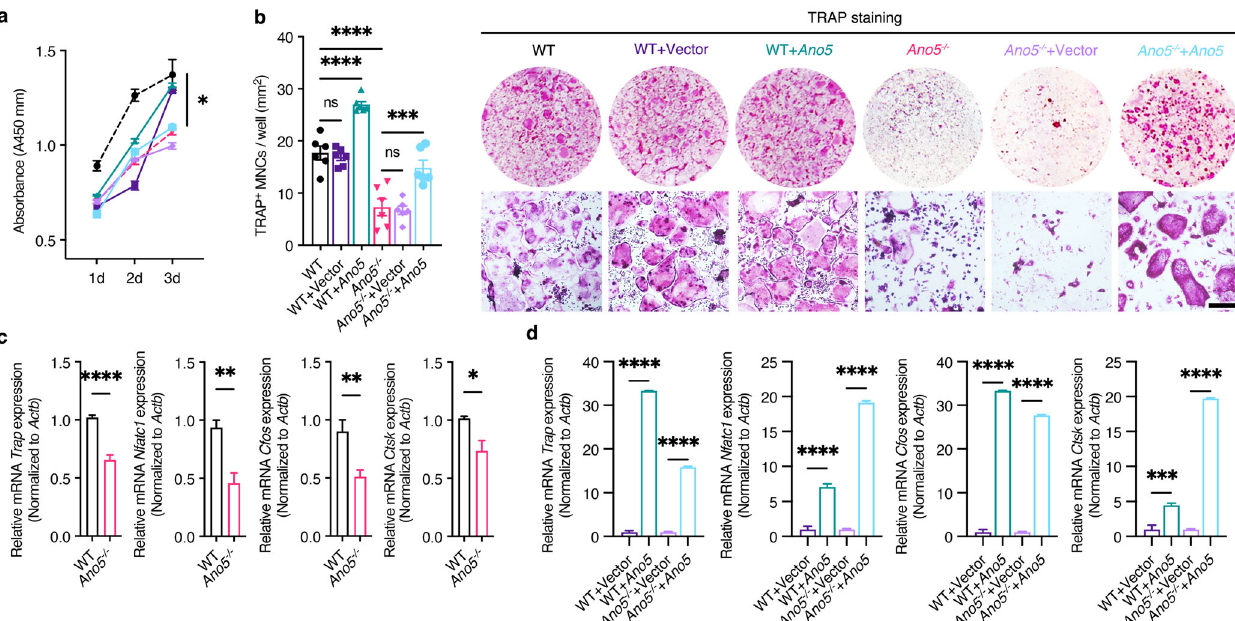
Fig. 4 Ano5 positively regulates osteoclast differentiation. a The proliferation of WT, Ano5 − / − BMMs, and those transduced with a control vector or Ano5 overexpression lentivirus by CCK-8 assay. b Representative images and quanti fi cation of TRAP staining after 5 – 7 days of osteoclast differentiation. Scale bar, 50 µm. c Relative mRNA expression of Trap, Nfatc1, Cfos, and Ctsk in osteoclasts differentiated from WT, Ano5 − / − BMMs and d those transduced with a control vector or Ano5 overexpression lentivirus. All results are representative of data generated from at least three independent experiments. Data are represented as the mean ± SEM. Two-tailed Student ’ s t test (for c ) and two-way ANOVA followed by Tukey ’ s multiple comparisons test (for a , b , d ). * P < 0.05, ** P < 0.01, *** P < 0.001, **** P < 0.0001; ns: not signi fi cant P >